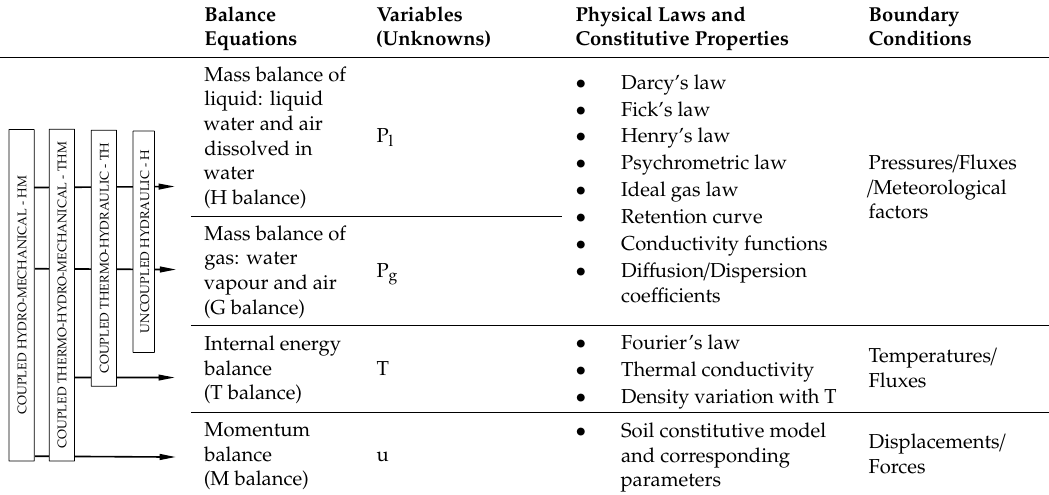
Table 1. Laws and equations controlling the thermo-hydro-mechanical state of the soils in the slope (after [20]